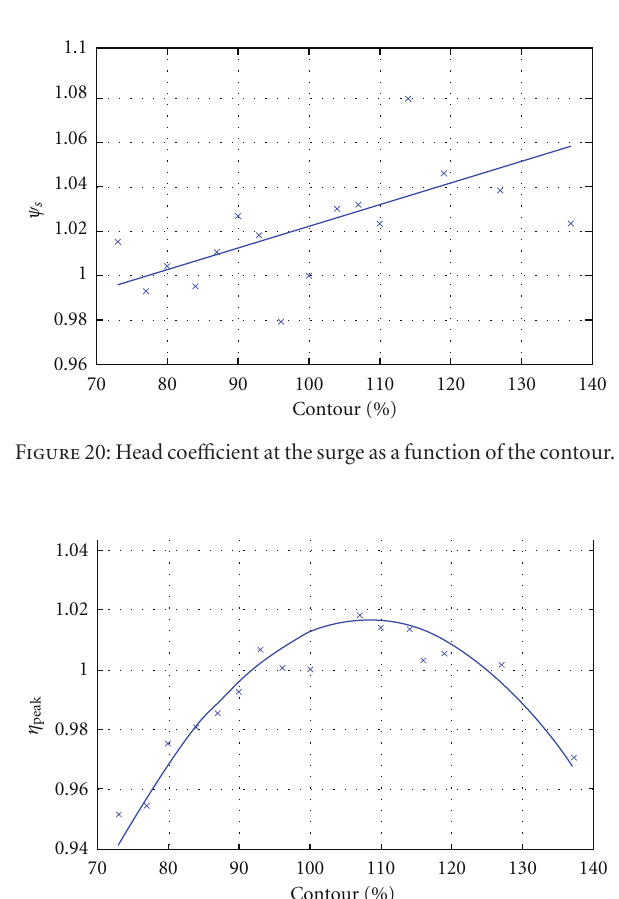
Figure 21: Peak e ffi ciency change with flow cuts.